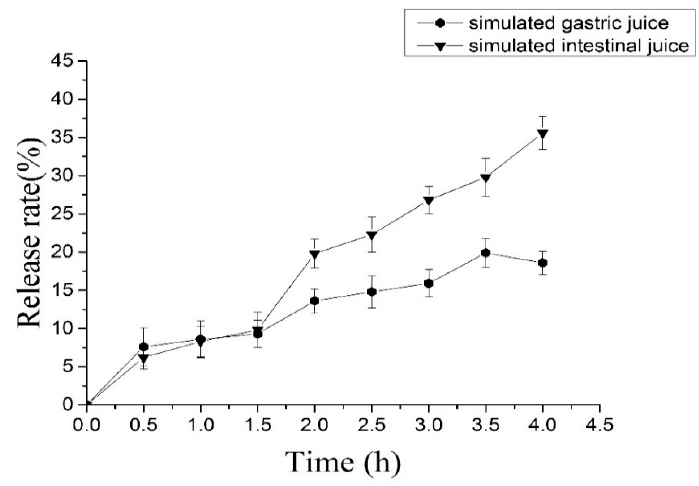
Figure 5. The effect of simulated gastrointestinal juice on C3G nanoliposomes. Data reported are the mean values ± standard variation of three replications.